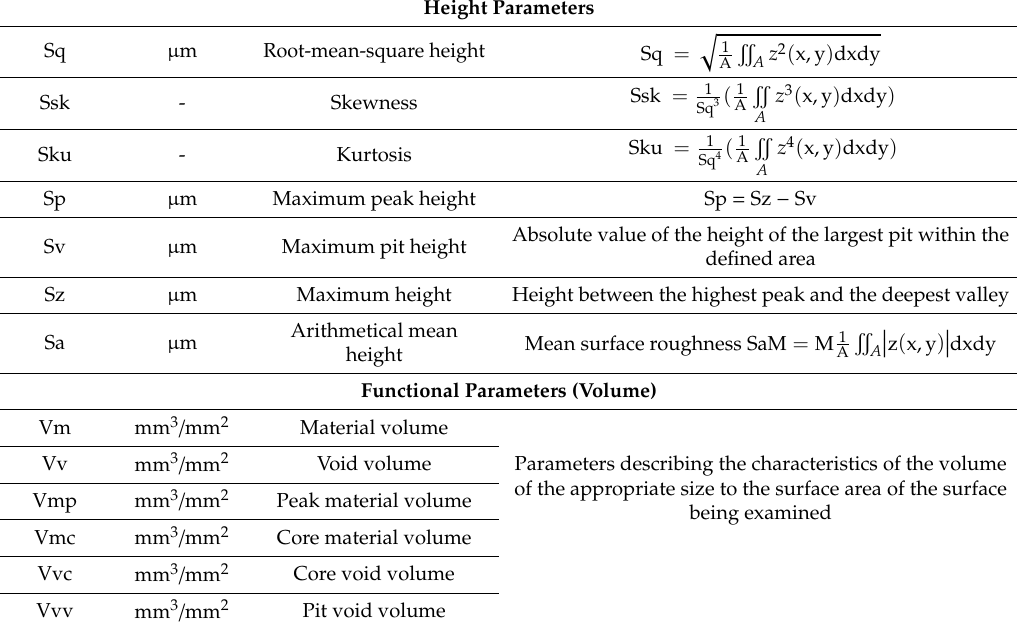
Table 4. Selected parameters for the fatigue fracture surface description according to ISO 25178. Height